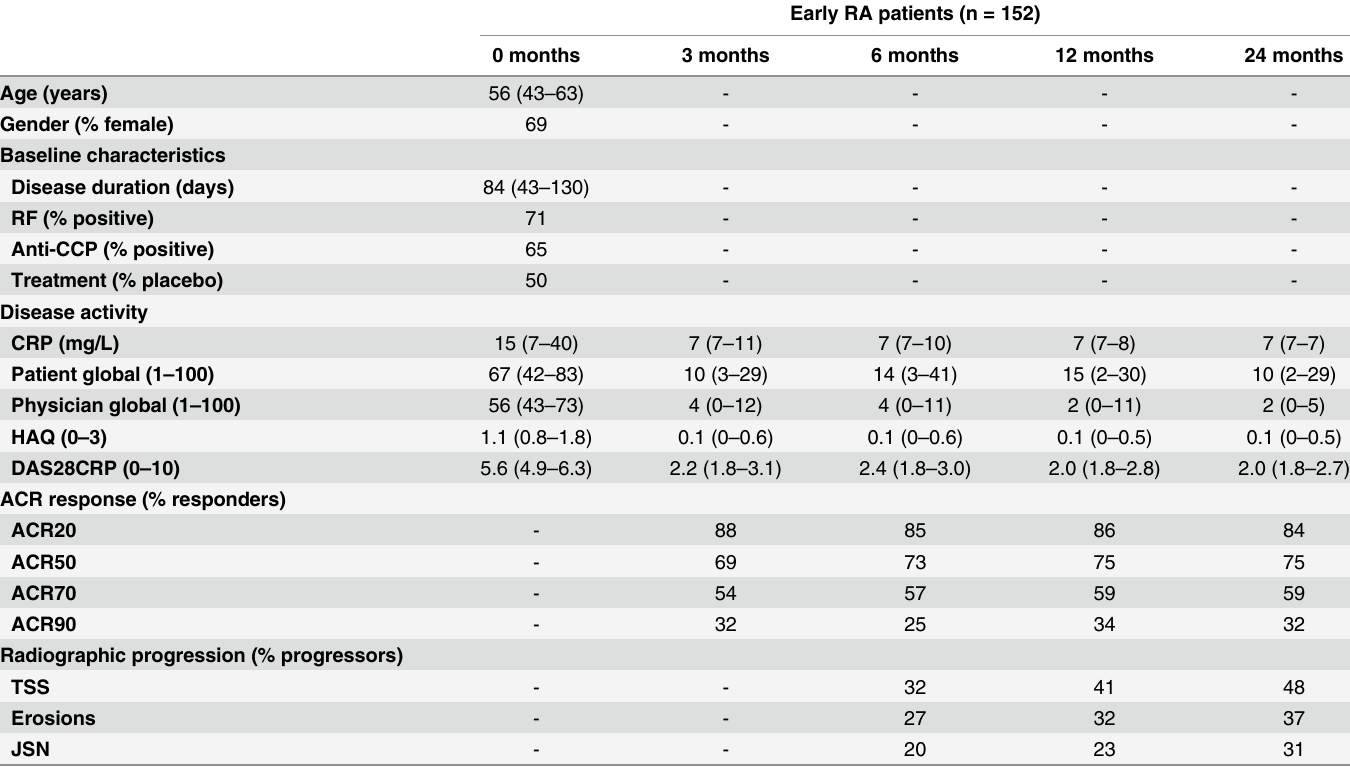
Table 1. Characteristics of the early treatment na ï ve RA